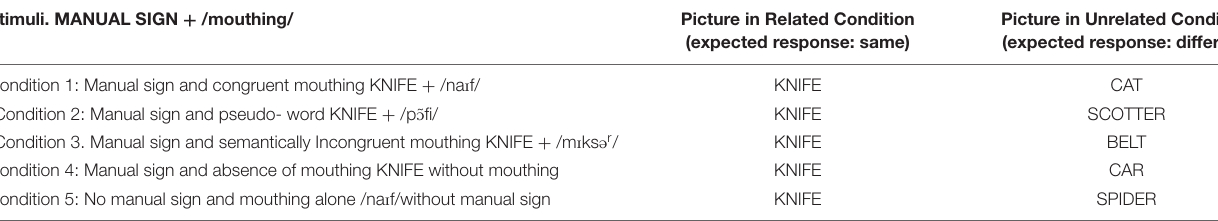
TABLE 1 | The five experimental conditions presented in the lexical decision